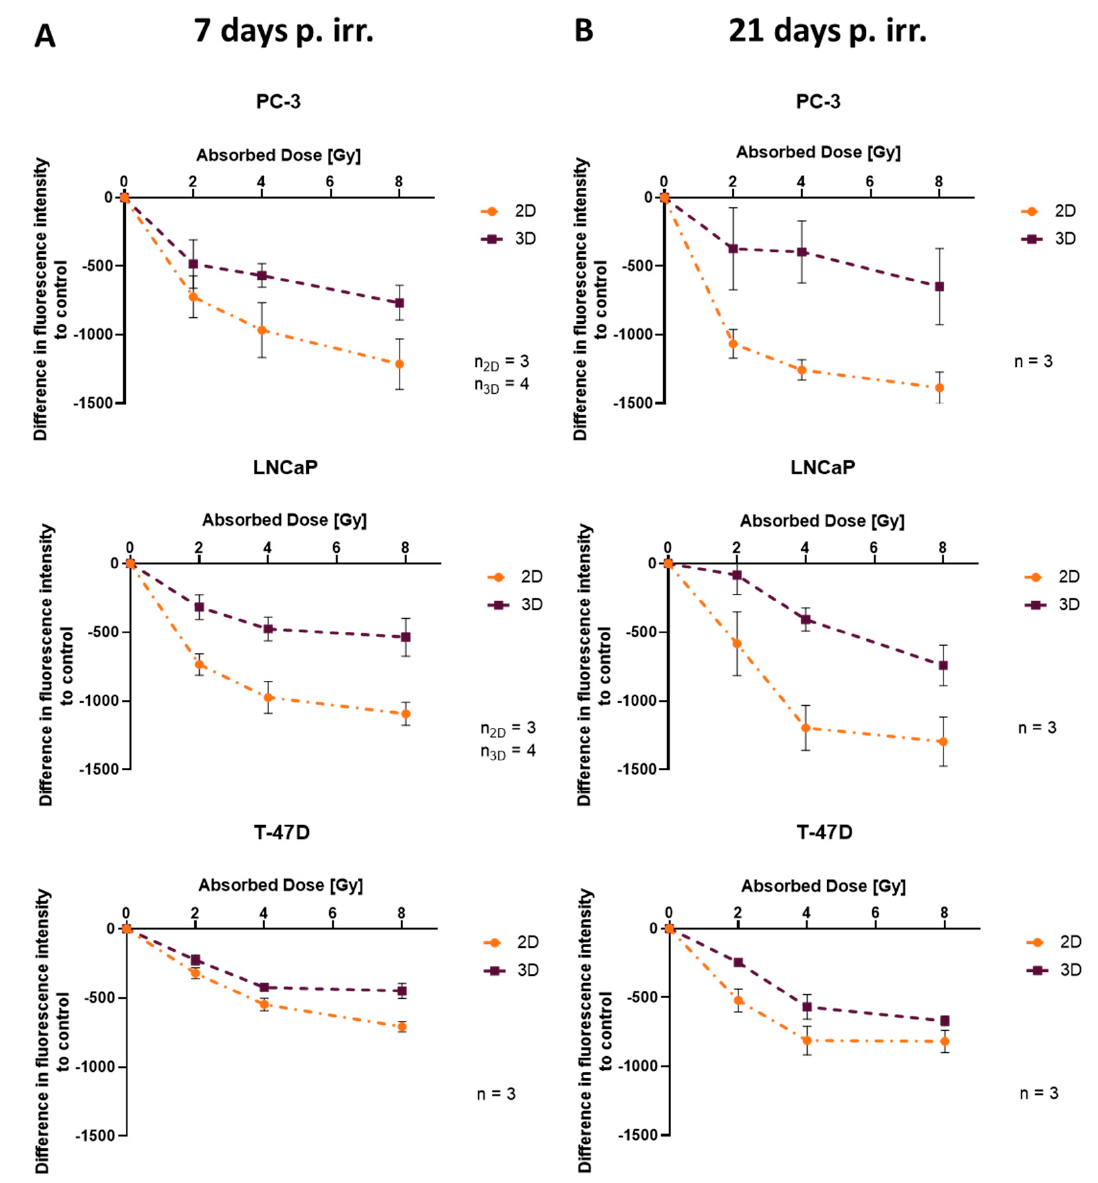
Figure 5. Assessment of difference in fluorescence intensity (metabolic activity) to control between 2D and 3D ( A ) 7 and ( B ) 21 days after irradiation; plotted as mean ± standard deviation from three to four independent experiments ( n = 3–4), each performed in triplicate; p. irr. = post irradiation.